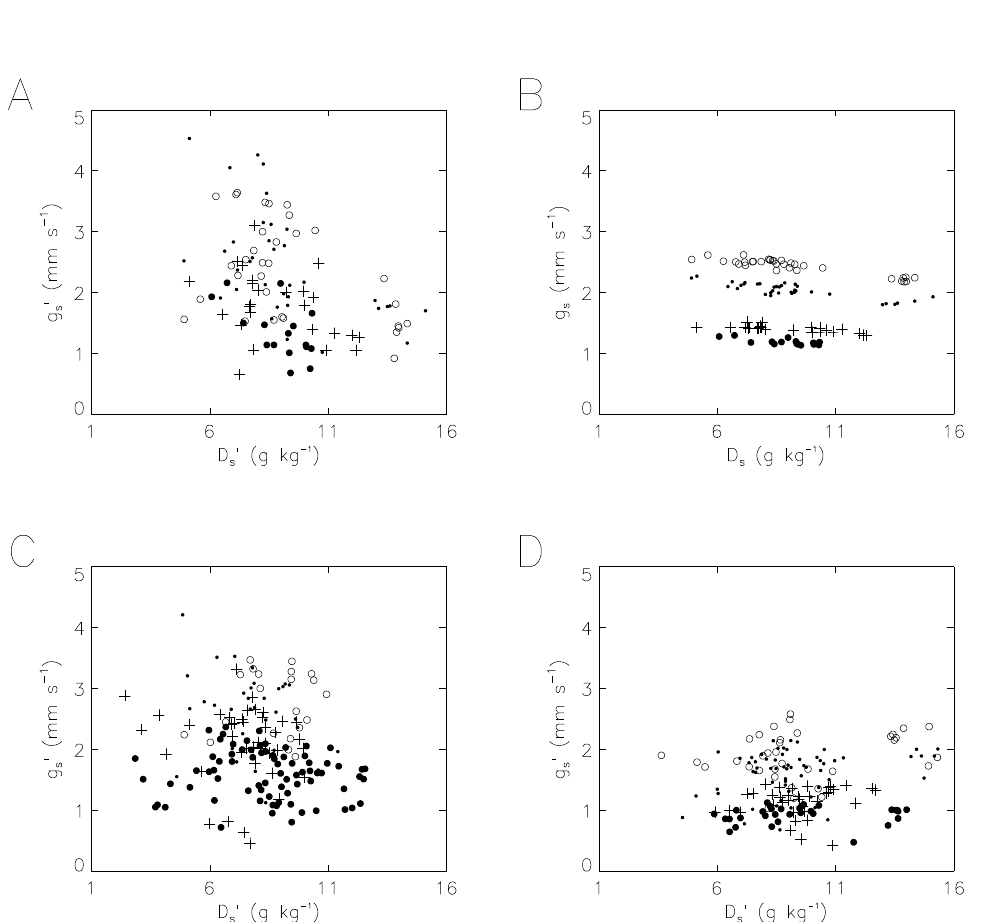
Fig. 2. Observed and simulated stomatal conductance of the Le-Bray forest versus leaf-to-air saturation deficit, for various soil mois- ture conditions: values of the normalised extractable soil moisture content, comprised in the intervals 0.10–0.25, 0.30–0.45, 0.70–0.80, 0.9–1.0 (solid circles, pluses, points, and open circles, respectively). (A, C, D) Canopy-level conductance g 0 s vs. effective